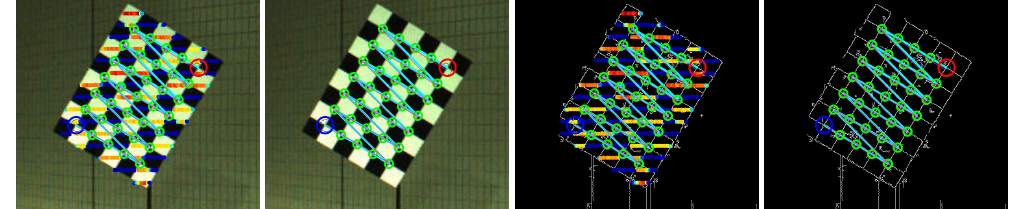
Figure 18. Re-projected corners and points of the chessboard (best viewed when zoomed in). Big green circles and cyan lines indicate the detected corners. Small pink circles in big green circles and pink lines indicate re-projected corners estimated from the point cloud. Big blue and red circles represent the start and end for counting the corners. Blue points indicate low reflectance intensity and red points indicate high reflectance